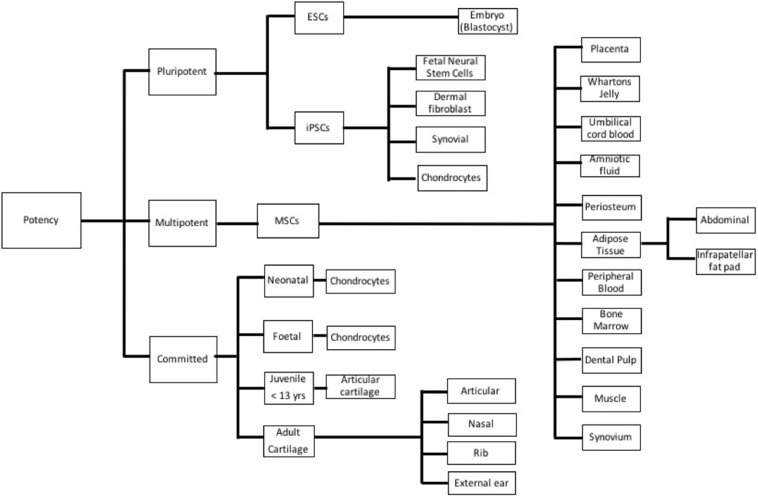
Different cell types used in cartilage tissue engineering based on potency. ESC, Embryonic stem cell; iPSC, Induced pluripotent stem cell; and MSC, Mesenchymal stem cell.